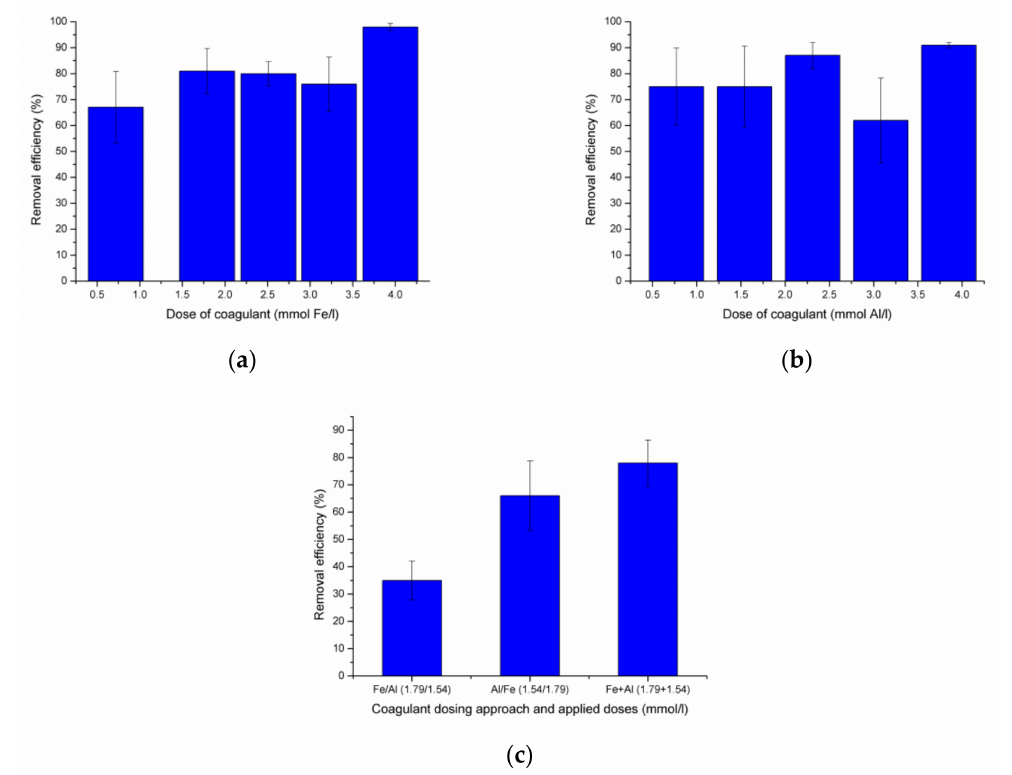
Figure 8. Efficiency of removal of textile fibers from a synthetic matrix by coagulation with ( a ) FeCl 3 , ( b ) PACl, and ( c ) a combination of FeCl 3 and PACl (error bars show standard deviation of